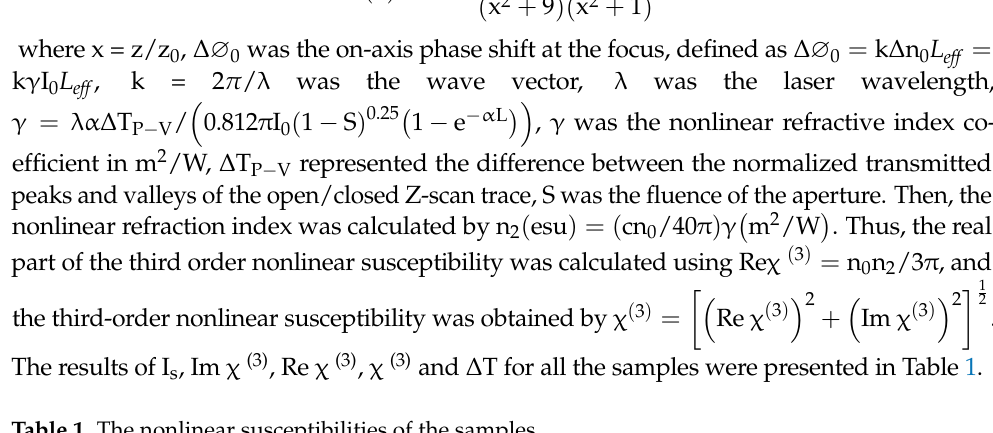
Table 1. The nonlinear susceptibilities of the